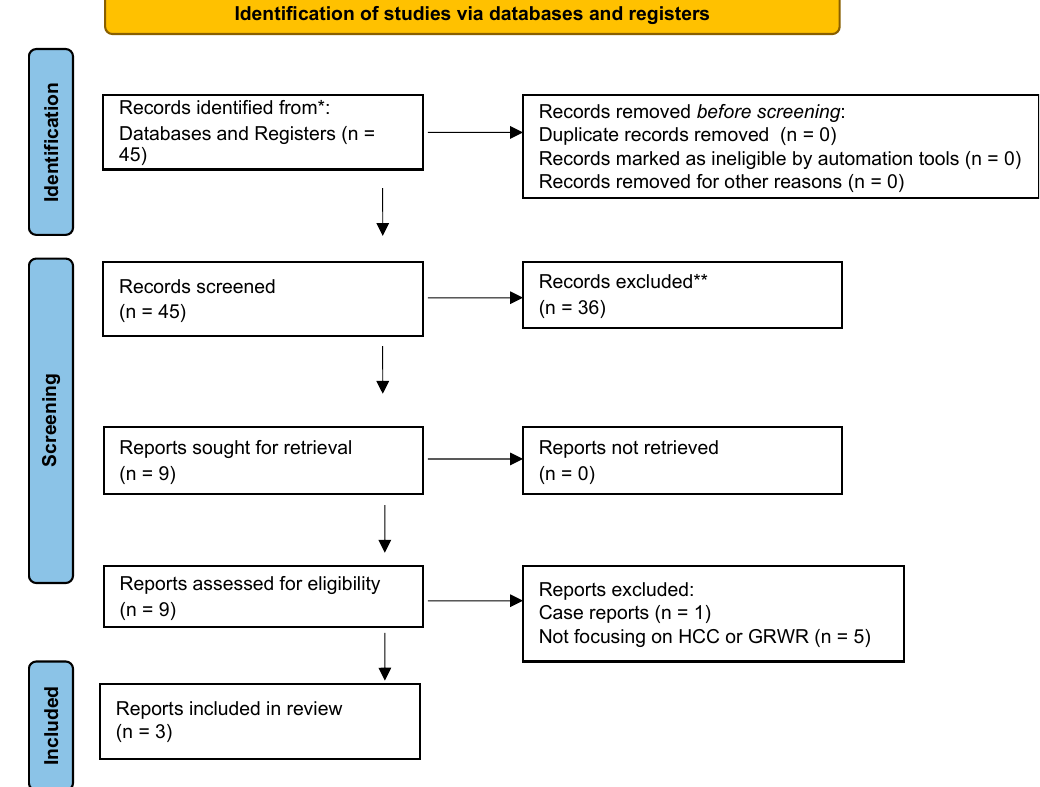
Figure 1. PRISMA fl owchart. * MEDLINE, EMBASE and Web of Science; ** Sixteen studies were Figure 1. PRISMA flowchart. * MEDLINE, EMBASE and Web of Science; ** Sixteen studies were used to give an overview of survival and SFSS rates after LDLT using a cut-o ff for GRWR at <0.8 % used to give an overview of survival and SFSS rates after LDLT using a cut-off for GRWR at vs. ≥ 0.8 %. SFSS: small for size syndrome. <0.8 % vs. ≥ 0.8 %. SFSS: small for size